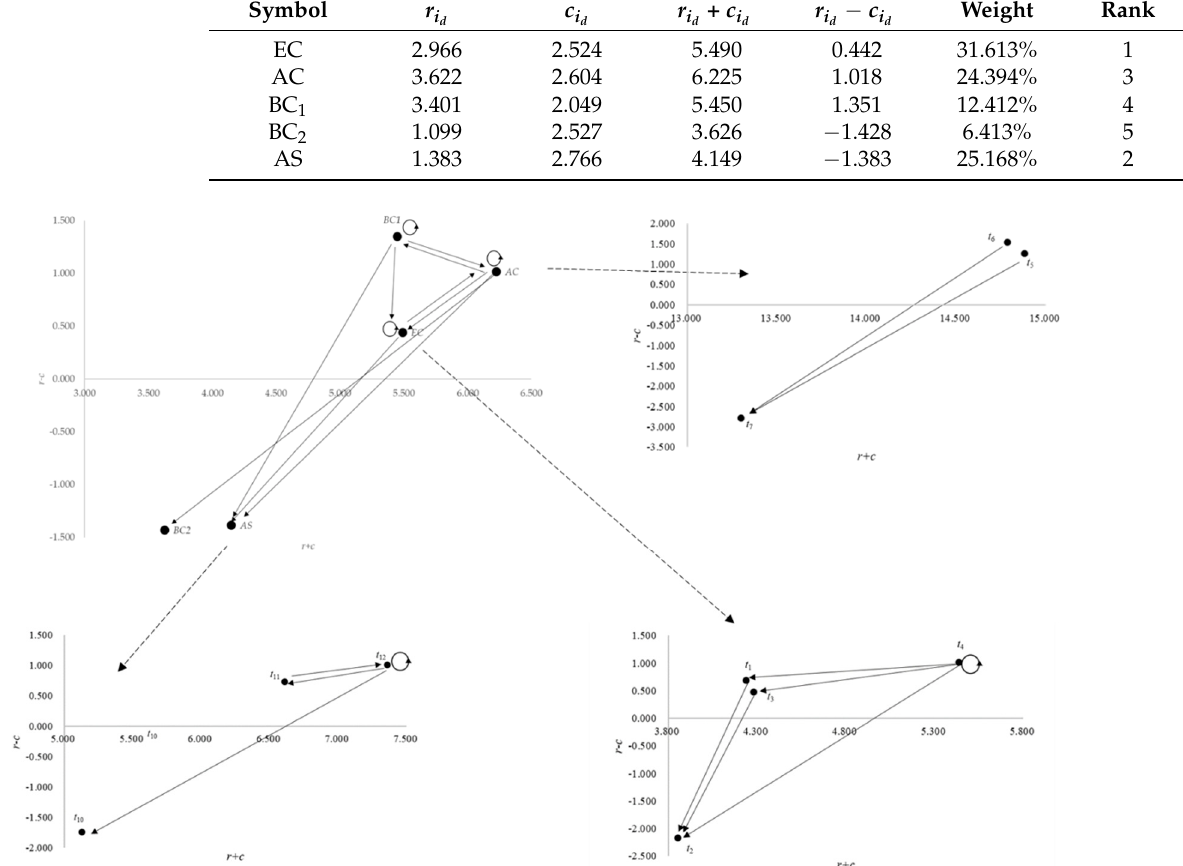
Figure 2. The Figure 2. The IRM.